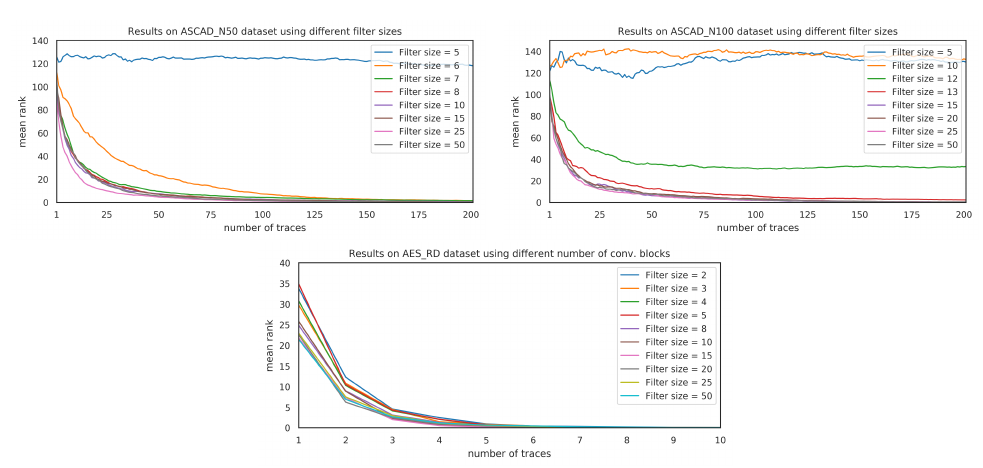
Figure 7: Effect of the filter size on the performance of a network when attacking the datasets ASCAD_N50 (left), ASCAD_N100 (right), and AES_RD